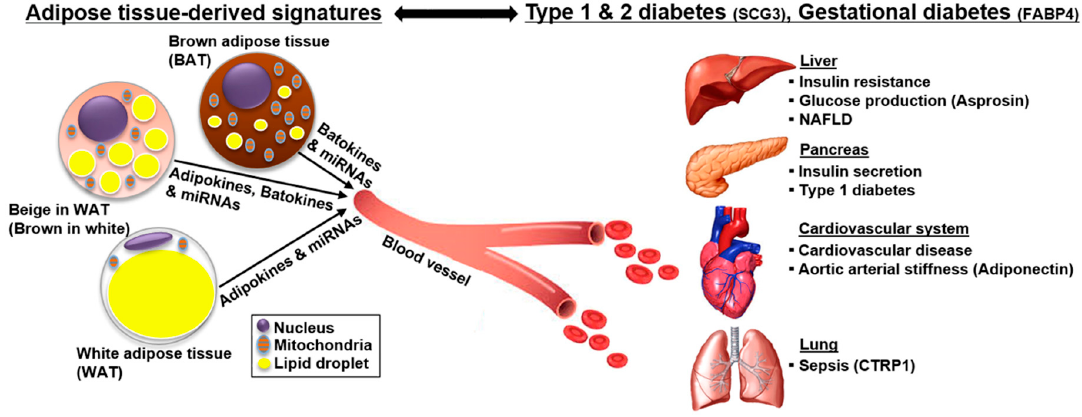
Figure 1. The role of adipokines in diabetes and its related pathogenic phenomena. Adipokines play a critical role in maintaining systemic energy homeostasis. Diabetes is accompanied by several pathogenic phenomena, such as obesity, sepsis, aortic arterial stiffness (AS), and nonalcoholic fatty liver disease (NAFLD). Pathologically disturbed adipokines in diabetes can act as biomarkers for the diagnosis and prediction of the risk for diabetes and its related pathogenic conditions. Further, understanding the role of adipokines in various pathogenic conditions will provide clues for the treatment of diabetes. Abbreviations: SCG3, secretogranin III; FABP4, fatty acid binding protein 4;